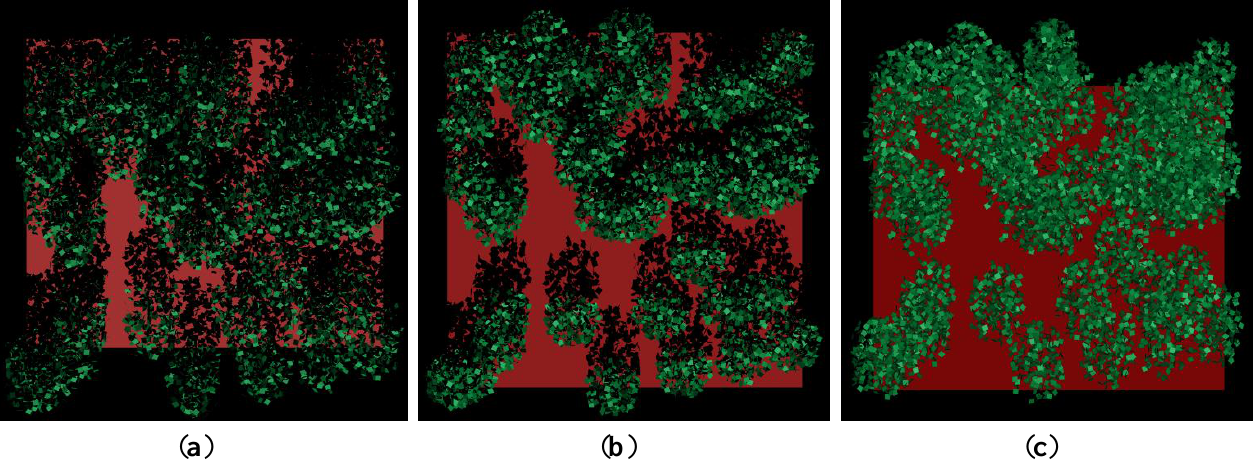
Figure 3. The downward-looking synthetic images from constructed 3D scene of the YJP site under clear-sky conditions. The components in bright green, bright brown, dark green, and dark brown correspond to sunlit foliage, sunlit background, shaded foliage and shaded background, respectively. ( a – c ) correspond to synthetic images generated in the principal plane with the view zenith angle θ of 30°, 0° and −30°, respectively. The solar zenith 𝑣 angle θ and solar azimuth angle φ are −30° and 180°, 𝑠 𝑠